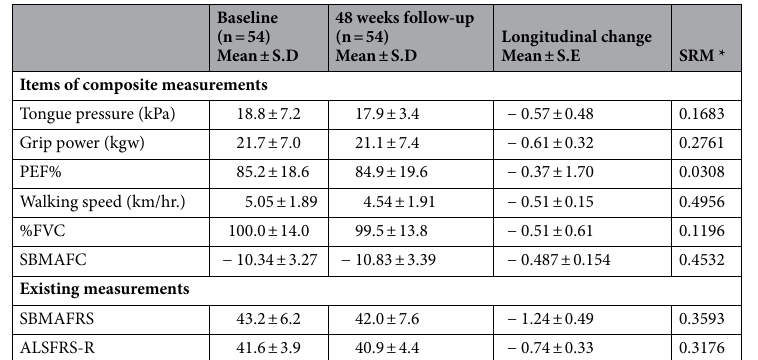
Longitudinal change Mean ±